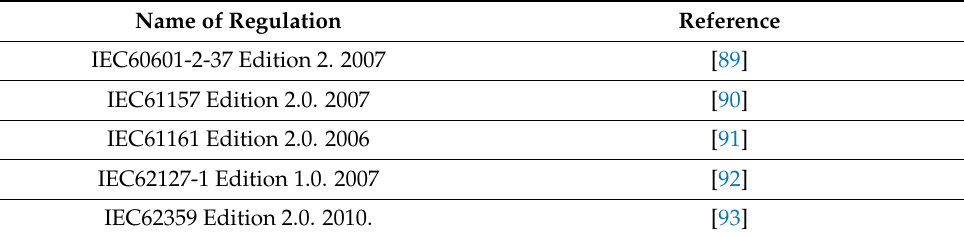
Table 9. International regulations related to the medical use of